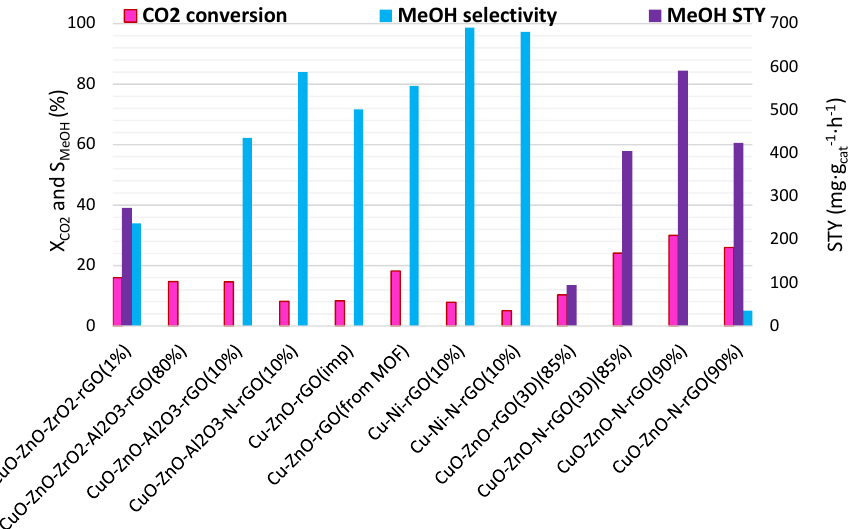
Figure 2. The results of CO 2 hydrogenation to methanol catalyzed by graphene derivative supported catalysts (data from references [24 – 33]).